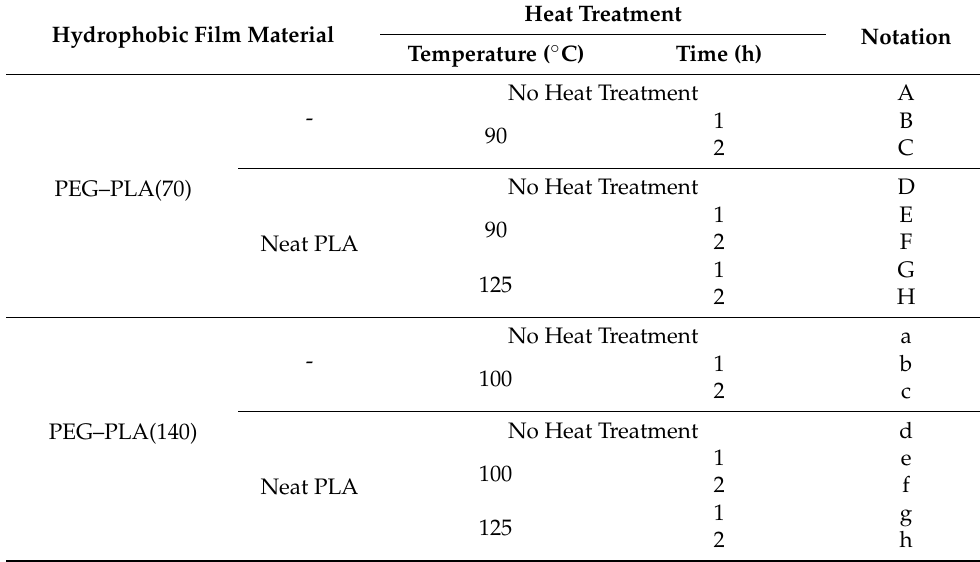
Table 2. Temperatures, durations, and notations used for PEG–PLA heat